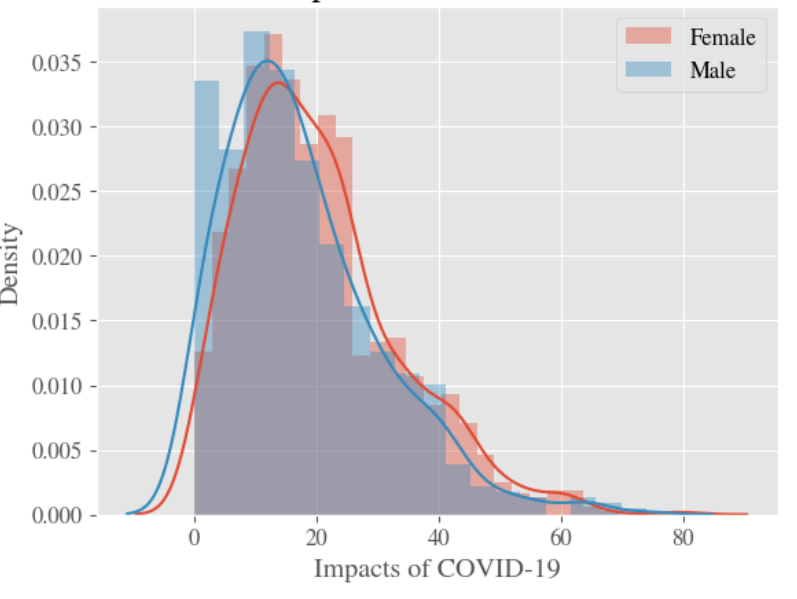
Figure 4. The Distribution of Levels of the Impacts of COVID-19 in Men and Women. The results of the bivariate analysis for men and women are shown in Table 3a,b, respectively. We identified the socio-demographic factors that were significantly associated ( p < 0.2) with psychosocial well-being among men and women at the bivariate level. Table 3. Bivariate analysis of socio-demographic factors and psychosocial well-being among men and